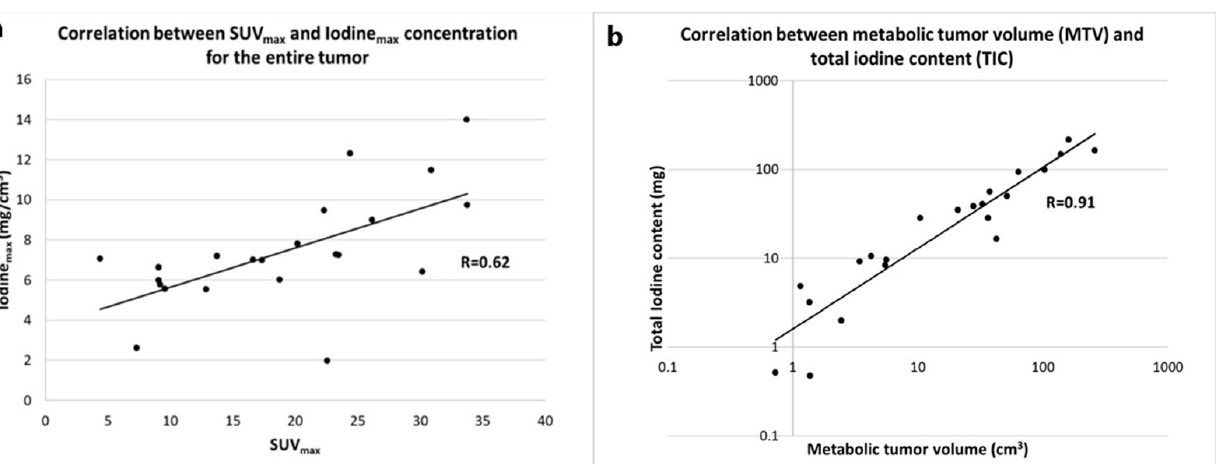
Table 2. A summary of Pearson correlations of FDG uptake and iodine-related parameters at differ- ent thresholds of metabolic values with accompanying p -values. SUV: standard uptake value; MTV: metabolic tumor volume; TLG: total lesion glycolysis; r: Pearson correlation coefficient. All param- eters that are related to volume (MTV; TLG; total iodine content) were log 10 -transformed to achieve normal distribution before calculating the correlation coefficient.